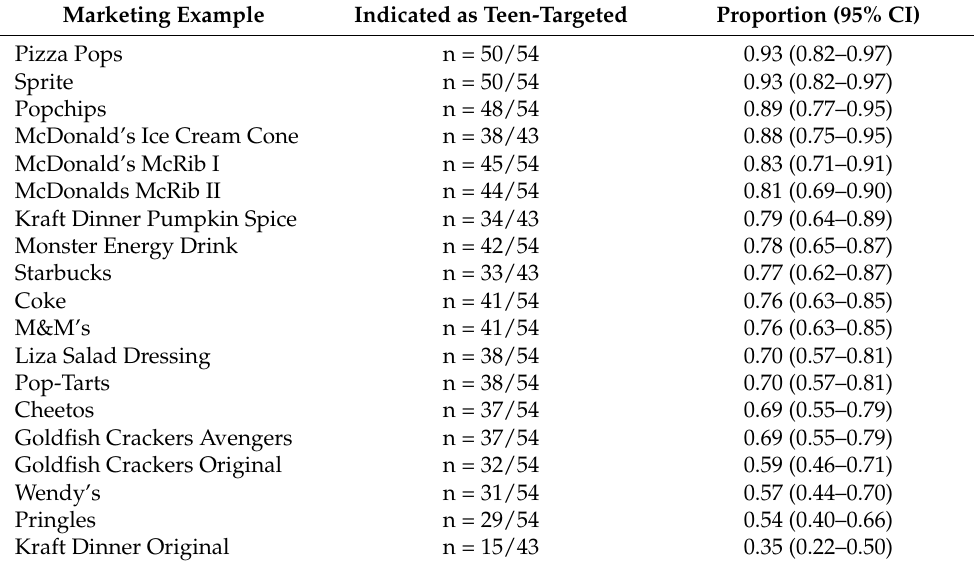
Table 4. The proportions of teens identifying the examples of food marketing as